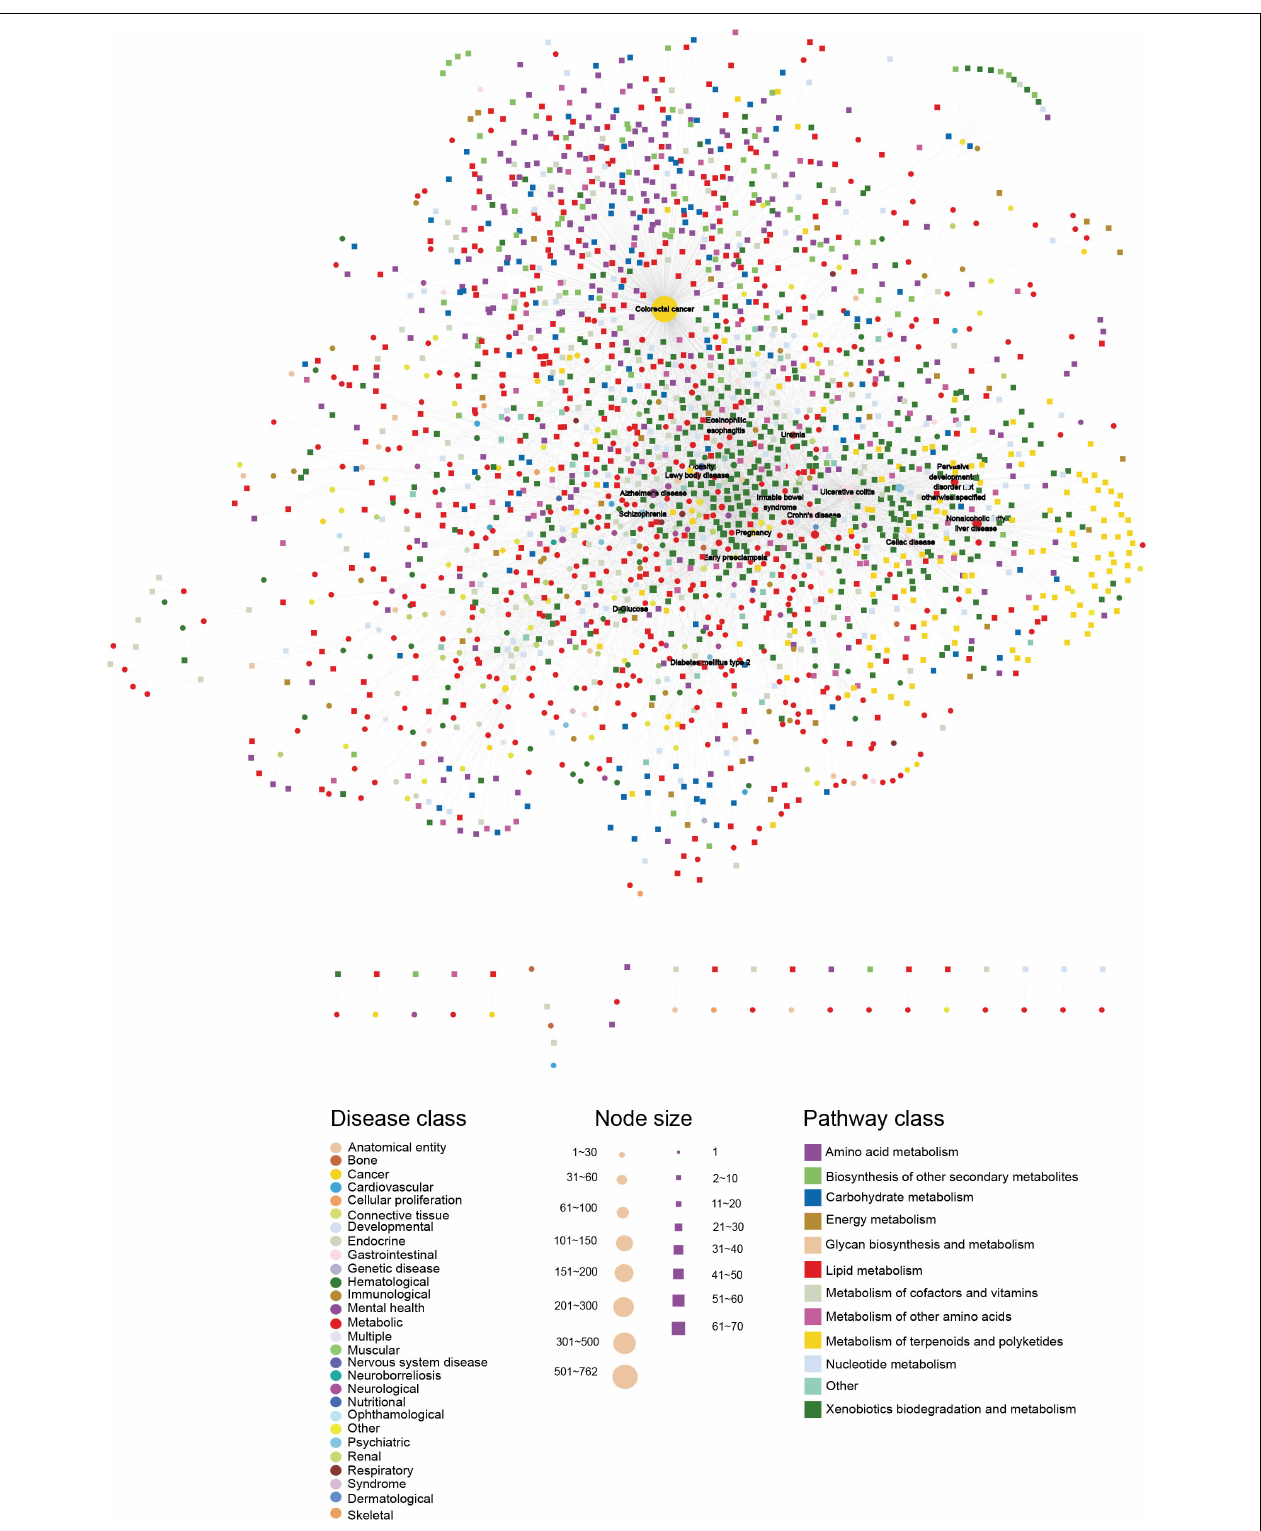
FIGURE 1 | The HDMN network. The circles and rectangles in the network correspond to diseases and metabolites, respectively. The edges represent connections between a disease and a metabolite. The node size is proportional to its degree. The nodes are colored according to 28 disease classes and 12 KEGG pathway categories. The network has a total of 2339 nodes (625 disease nodes,1714 metabolite nodes) with 5475 edges.